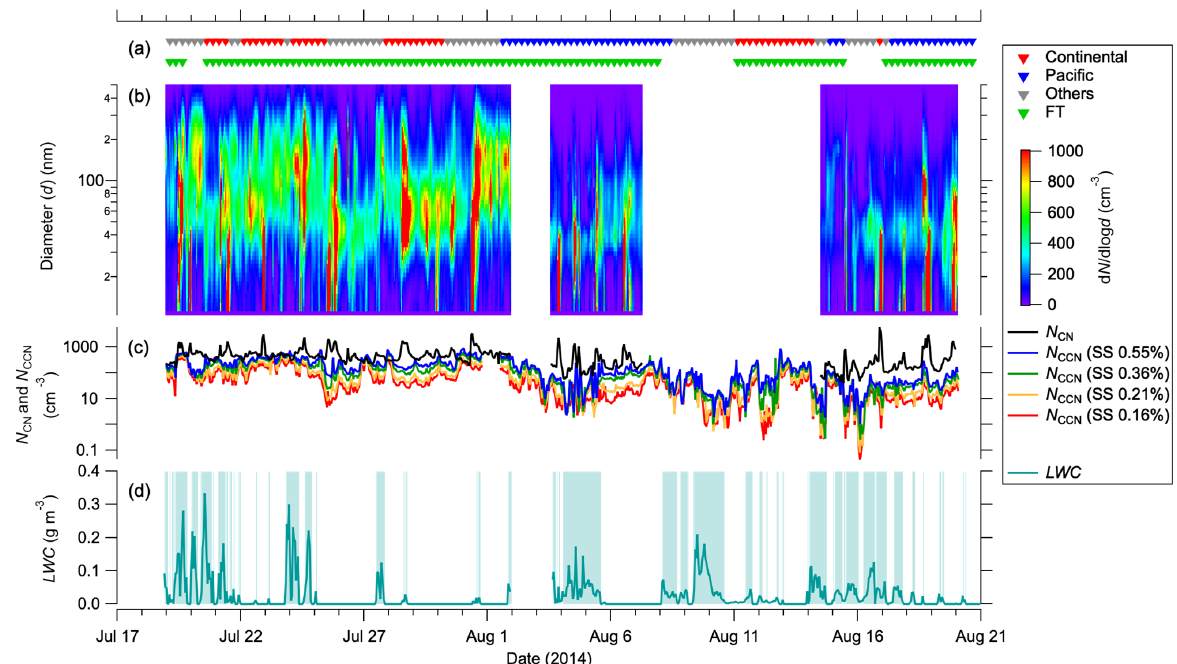
Figure 3. Temporal variations of ( a ) air mass origins, ( b ) air pressure (red line), precipitation (blue sticks), ( c ) air tempera- ture (red line), relative humidity (blue line), ( d ) wind speed (red lines) and wind direction (blue dots).